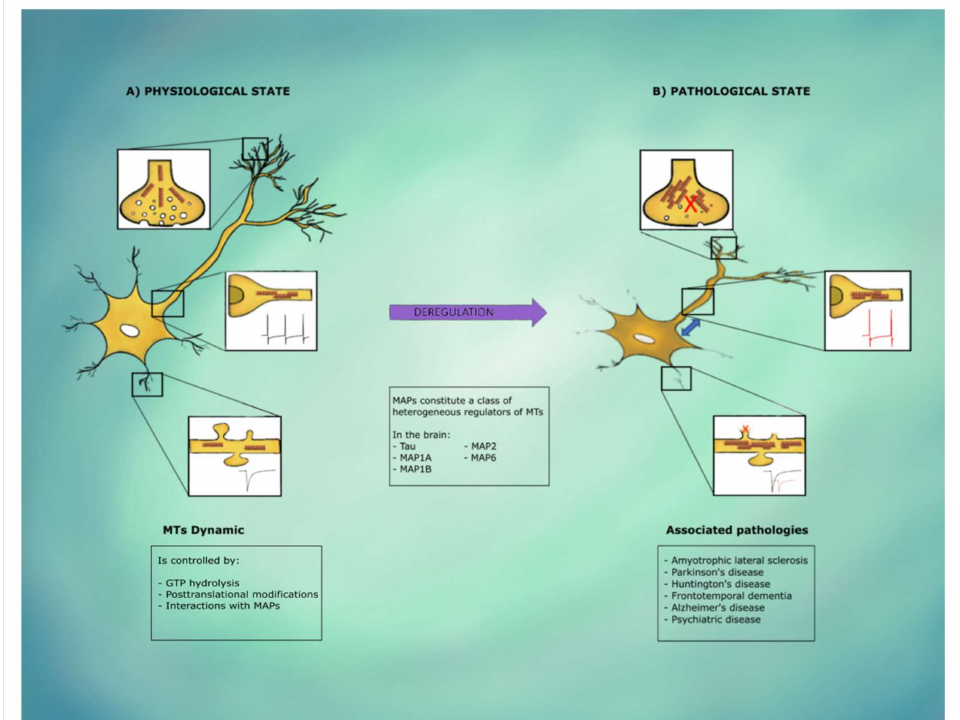
Figure 1. Microtubules (MTs) function in different neuronal compartments. In physiological con- ditions ( A ), MTs allow synaptic vesicles’ transport and recycling for proper synaptic transmission and plasticity. MTs contribute to the organization of the axon initial segment for action potential initiation and plasticity of intrinsic excitability. MTs are also capable of invading dendritic spines in an activity-dependent manner, for cargo delivery and postsynaptic plasticity regulation. However, when MTs dynamics and stability processes exceed the normal homeostatic range, under pathologi- cal conditions ( B ), there are MTs-dependent alterations in synaptic transmission due to inefficient synaptic vesicles’ transport, aberrant firing activity due to the relocation of the axon initial segment, loss of postsynaptic plasticity and alterations in dendritic spines due to reduced responsivity of MTs located in the dendritic